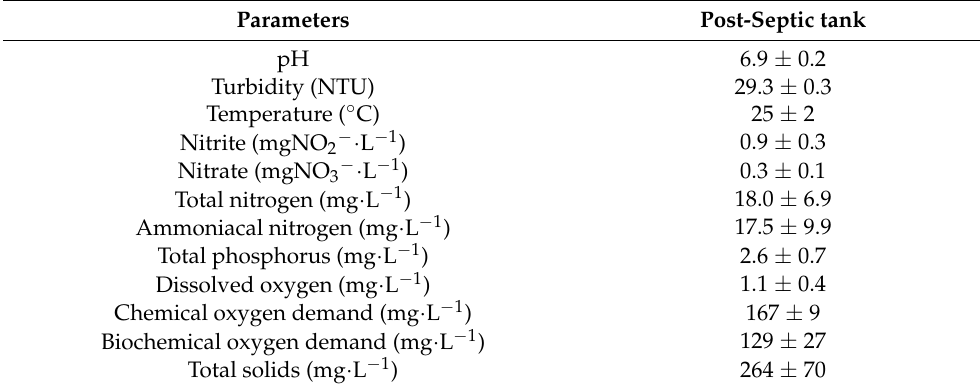
Table 1. Physicochemical characteristics of the post-septic tank domestic wastewater (n =